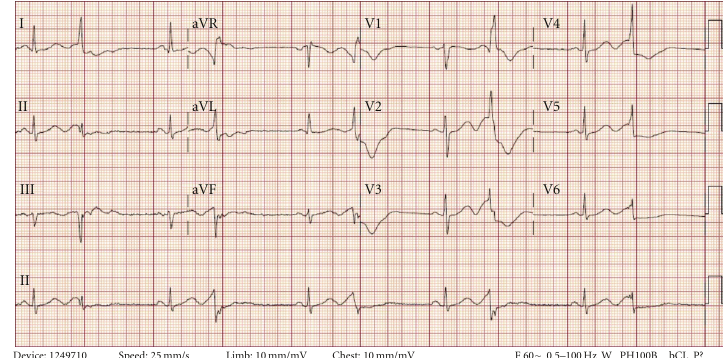
Figure 2: Initial 12 lead EKG in emergency room showing ventricular bigeminy. QTc was 550 ms.